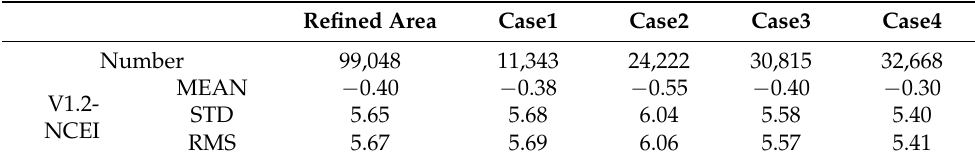
Table 8. Differences between refined gravity model and the testing shipborne data (in mGal). Refined